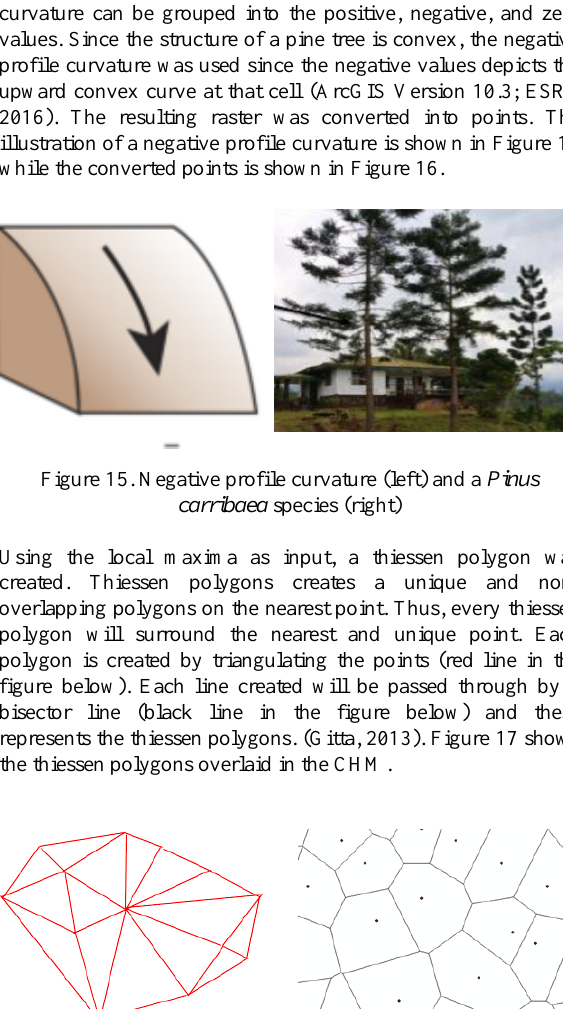
Figure 12. Surface scanning window (ArcGIS Version 10.3; ESRI, 2016)